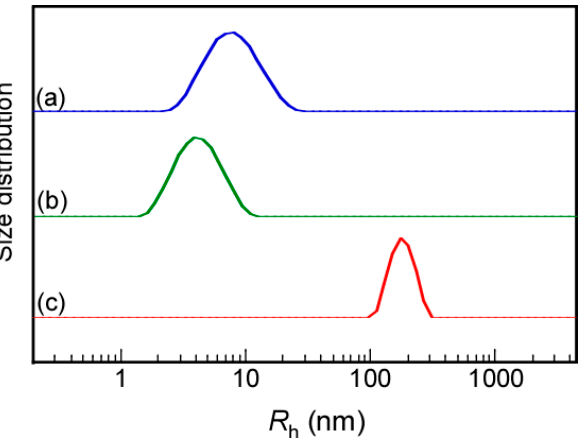
Figure 1. Hydrodynamic radius ( R h ) distributions of ( a ) PSBP at 2.0 g/L (6.72 mM of SBP unit), ( b ) CTAB at 10 g/L (27.4 mM), and ( c ) the PSBP/CTAB complex, with a mixing ratio of 0.5 within a complex concentration of 0.084 g/L in a 0.1 M NaCl aqueous solution at 25 °C.